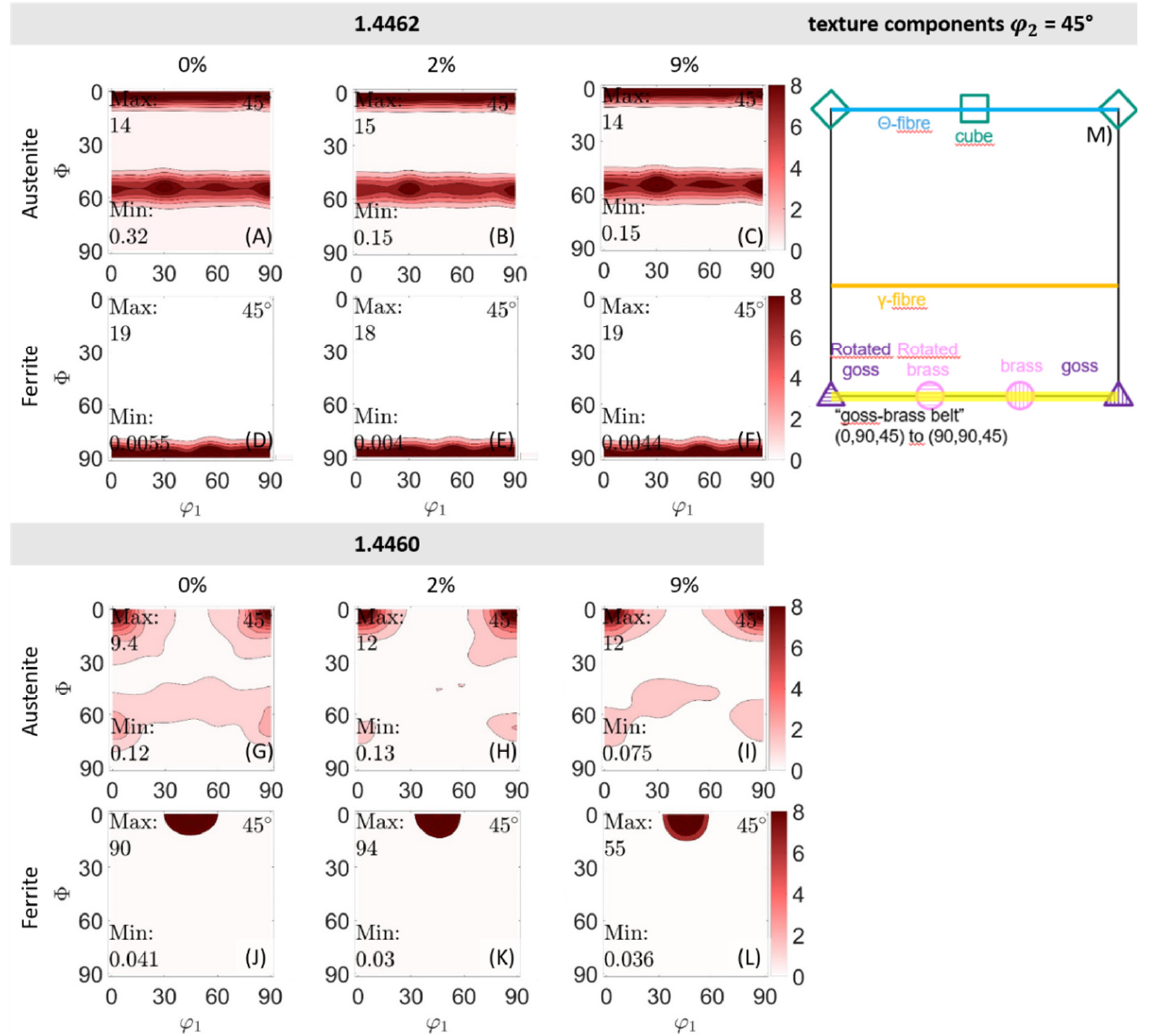
Figure 7. Evolution of the phase-specific texture in the two studied duplex steels represented by a section at ϕ 2 = 45 ◦ through the ODF. In addition, the previously achieved maximum degree of deformation in % total strain is indicated in each case. All figures are scaled similarly. ( A – F ) The phase-specific texture evolution in the 1.4462 duplex stainless steel. The results for the austenite phase are presented in ( A – C ) and for the ferrite phase in ( D – F ), respectively. ( G – L) The corresponding results for the 1.4460 duplex stainless steel. Again, the ODF sections are presented separately for the austenite phase ( G – I ) and the ferrite phase ( J – L ). In ( M ), the main texture components are highlighted for